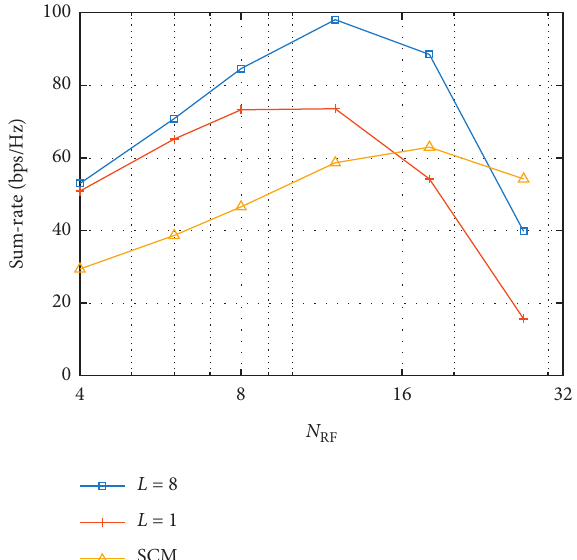
Figure 11: Sum-rate versus the SNR ( N